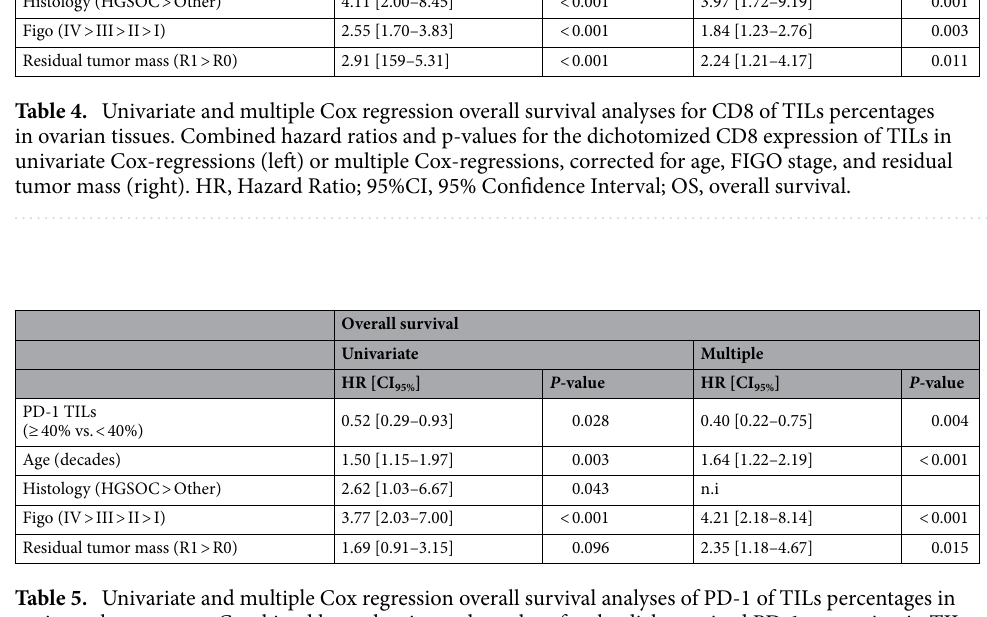
Table 5. Univariate and multiple Cox regression overall survival analyses of PD-1 of TILs percentages in peritoneal metastases. Combined hazard ratios and p-values for the dichotomized PD-1 expression in TILs in univariate Cox-regressions (left) or multiple Cox-regressions, corrected for age, FIGO stage, and residual tumor mass (right). HR, Hazard Ratio; CI 95% , 95% Confidence Interval; OS, overall survival; n.i., not included; according selection by the backward selection method minimizing the Akaike Information Criterion